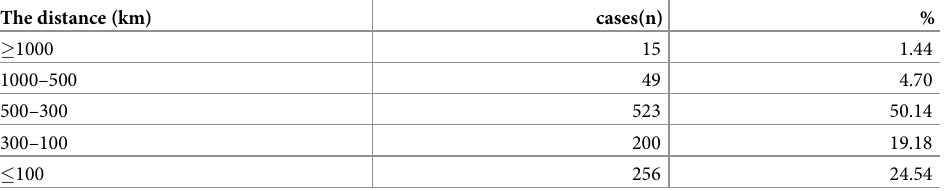
Table 2. The distance between secondary hospitals that apply for COVID-19 remote consultation and telemedi- cine consultation center (n = 1043). The distance (km)